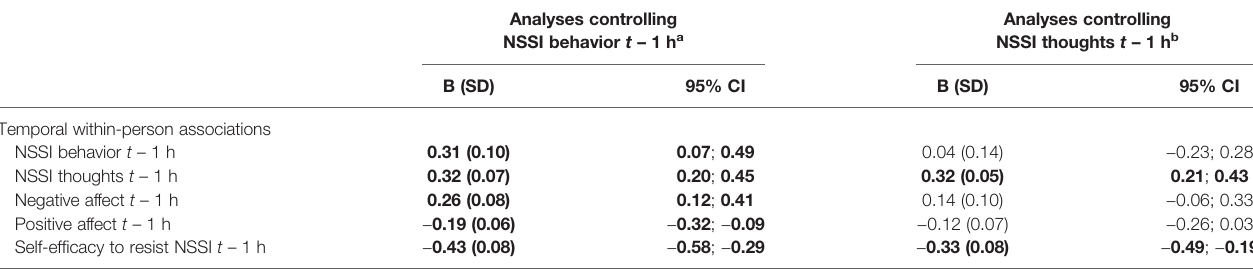
TABLE 5 | Temporal within-person associations between affective states, self-ef fi cacy to resist NSSI, and non-suicidal self-injury.